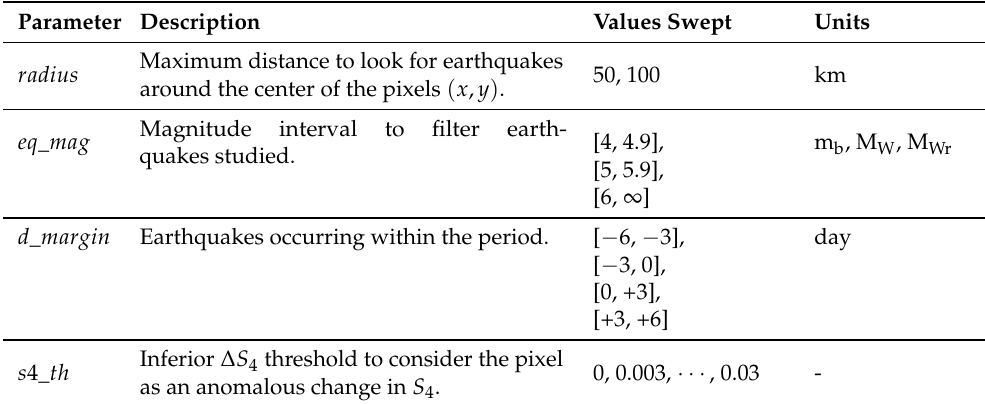
Table 2. Description of the parameters swept to generate different confusion matrixes. Parameter